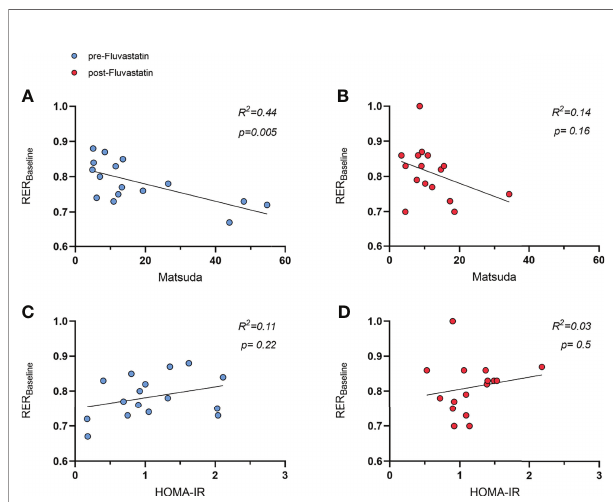
FIGURE 5 | Relation of respiratory exchange ratio (RER) and indices of insulin sensitivity. (A) Relation of Matsuda index to RER before intake of fl uvastatin, R² = 0.44, p = 0.005 and (B) after two weeks of fl uvastatin, R² = 0.14, p = 0.16. HOMA-IR before (C) and after two weeks (D) of fl uvastatin, R² = 0.11, p = 0.22 and R² = 0.03, p = 0.5,